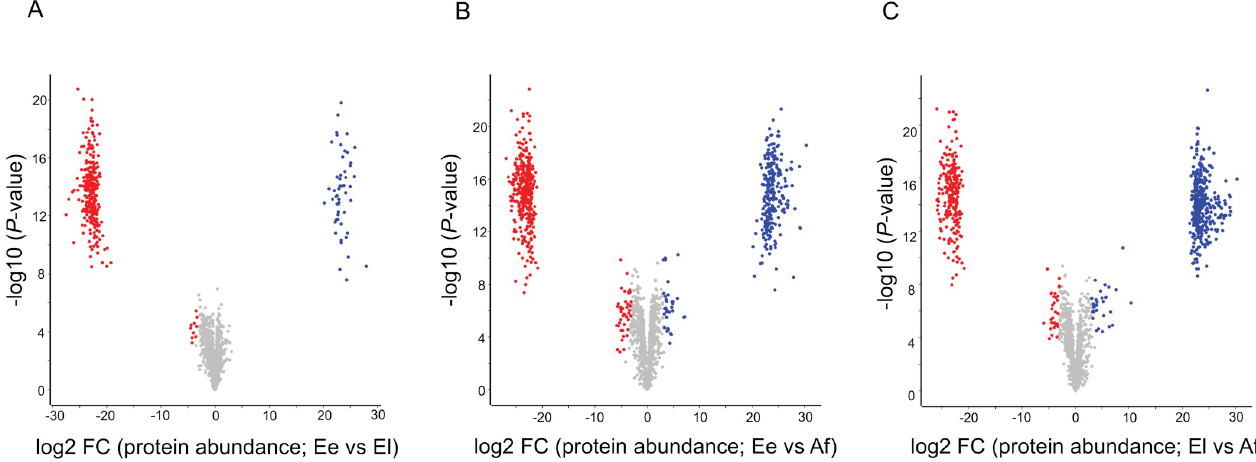
Fig 3. Volcano plots of proteins differentially expressed among eggs at an early stage (Ee), eggs at a late stage (El) of embryonation/development, and adult females (Af) of Sarcoptes scabiei (upon pairwise comparison). ( A ) Proteins differentially expressed between Ee (up-regulated, red) and El (up- regulated, blue). ( B ) Proteins differentially expressed between Ee (up-regulated, red) and Af (up-regulated, blue). ( C ) Proteins differentially expressed between El (up-regulated, red) and Af (up-regulated,